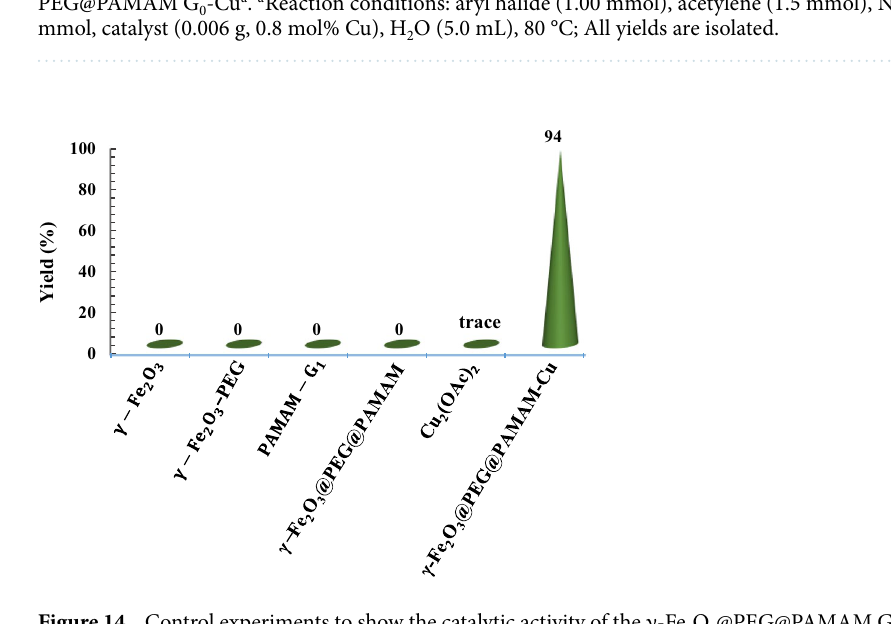
Figure 14. Control experiments to show the catalytic activity of the γ-Fe 2 O 3 @PEG@PAMAM G 0 -Cu for the Sonogashira model